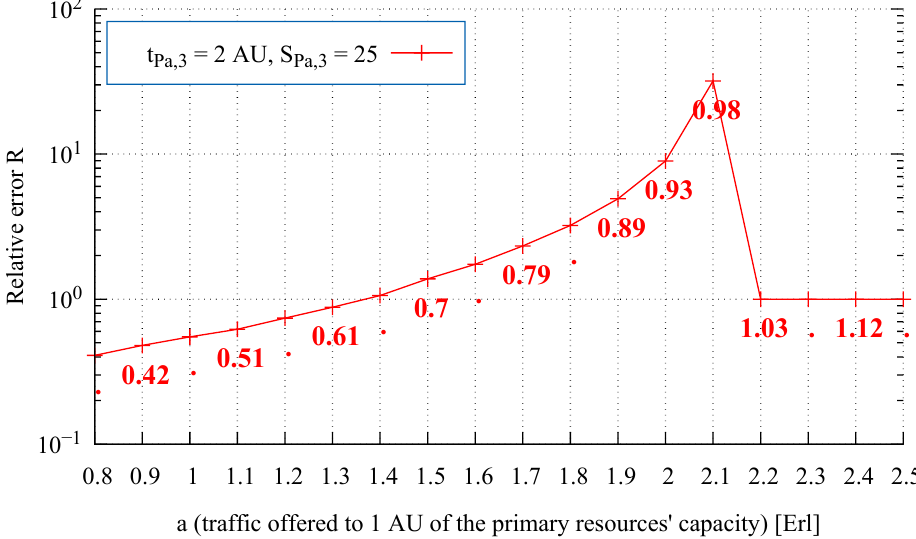
Figure 5. Relative error of the average value of overflow traffic, System 2, Resource 1 ( α values specified directly in the